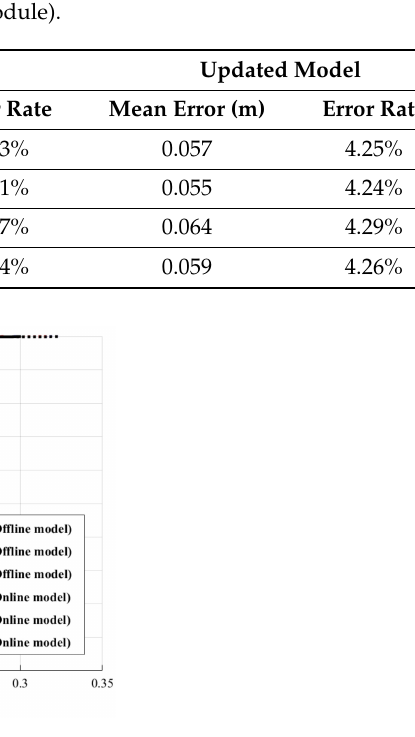
Figure 13. Qualitative comparison of stride-length estimation error between the offline model (SLE model without online learning module) and updated model (SLE model with online learning module).